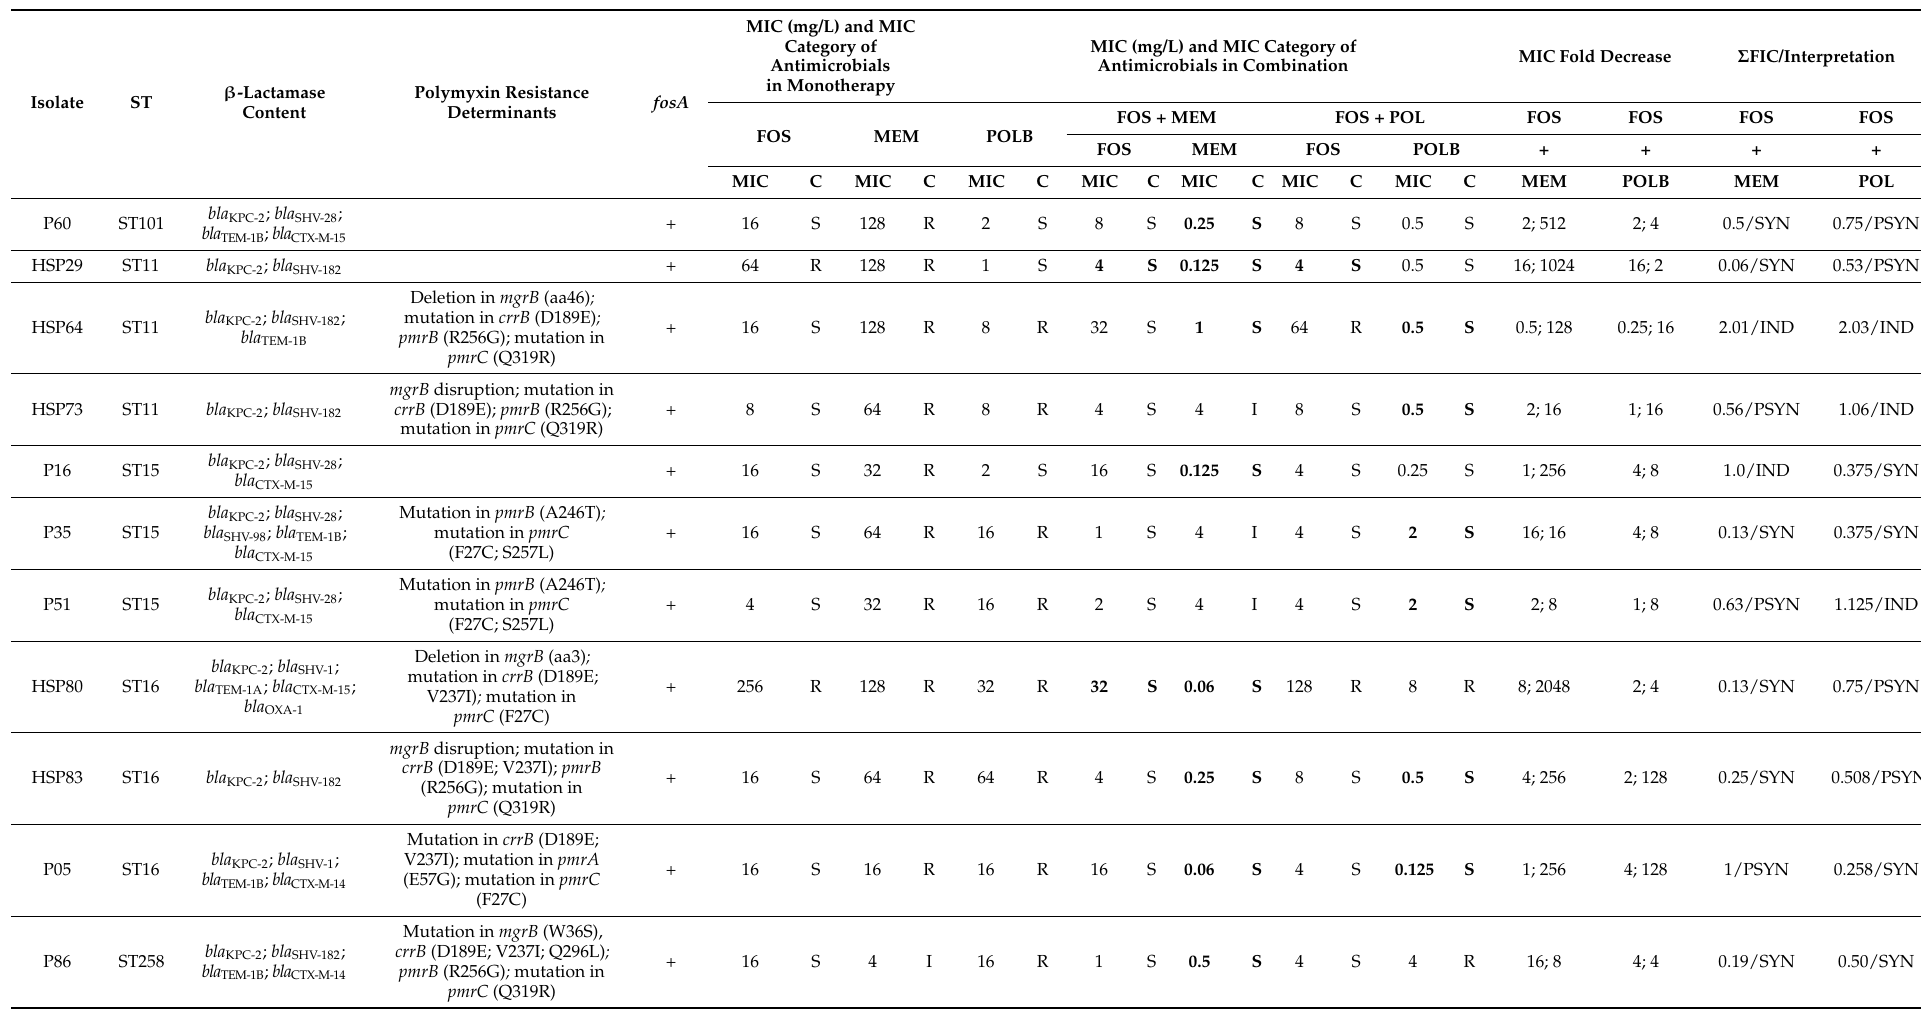
Table 1. CKA results and fosfomycin, β -lactams, and polymyxin resistance determinants for the isolates